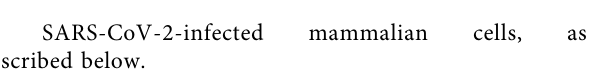
Frontiers in Chemistry |